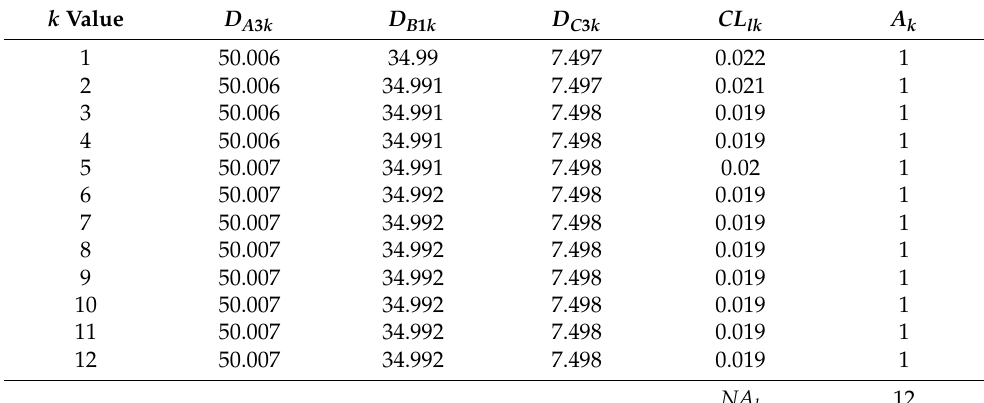
Table 8. Calculated clearance value for the first position bin